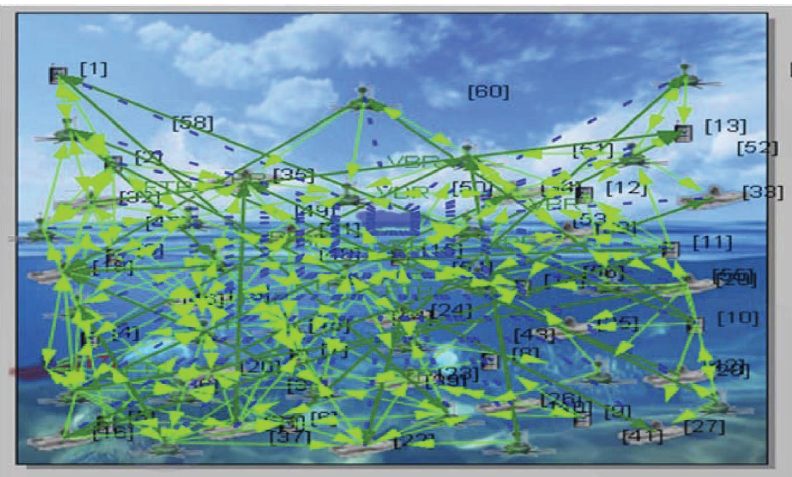
Figure 4: Proposed scenario of underwater wireless communication in X - Y visualization.